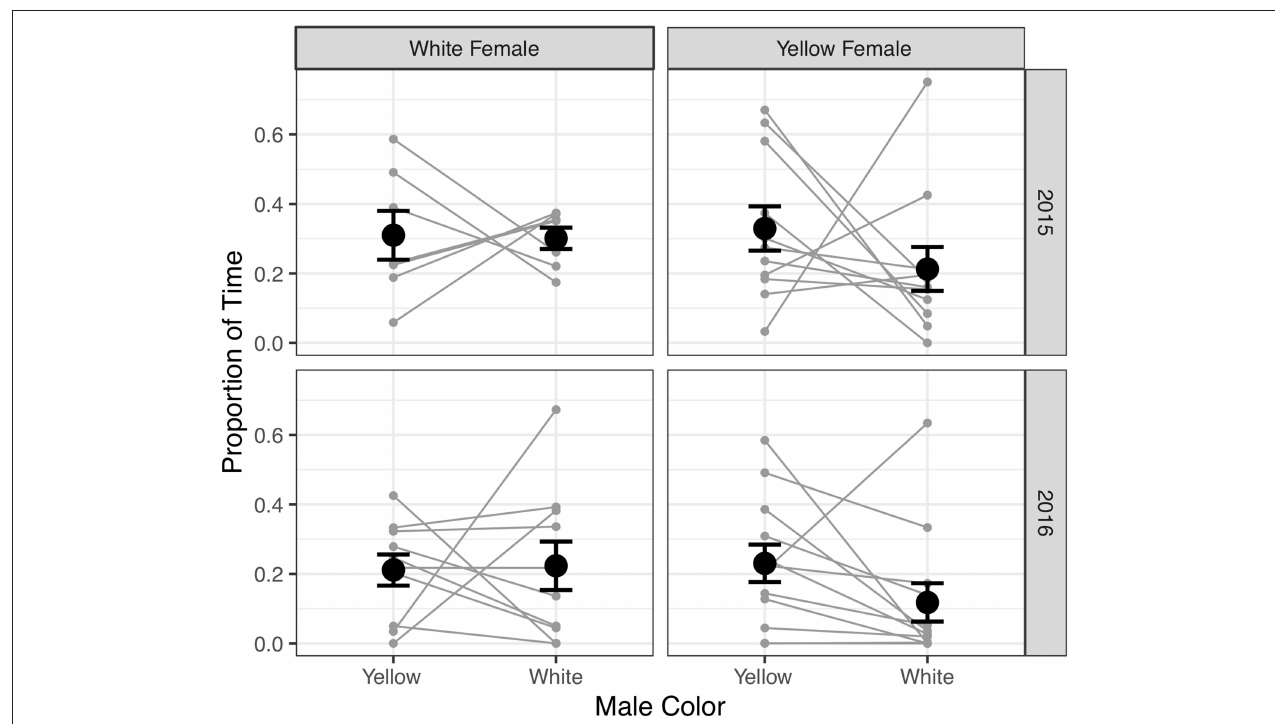
FIGURE 2 | The mean ± SE proportion of time white (left column) and yellow (right column) females spent near yellow or white males in the trials during 2015 (top row) and 2016 (bottom row). Each pair of gray points connected by a line indicates the values for a particular female such that lines with a negative slope indicate females who spent a greater proportion of trial time near yellow